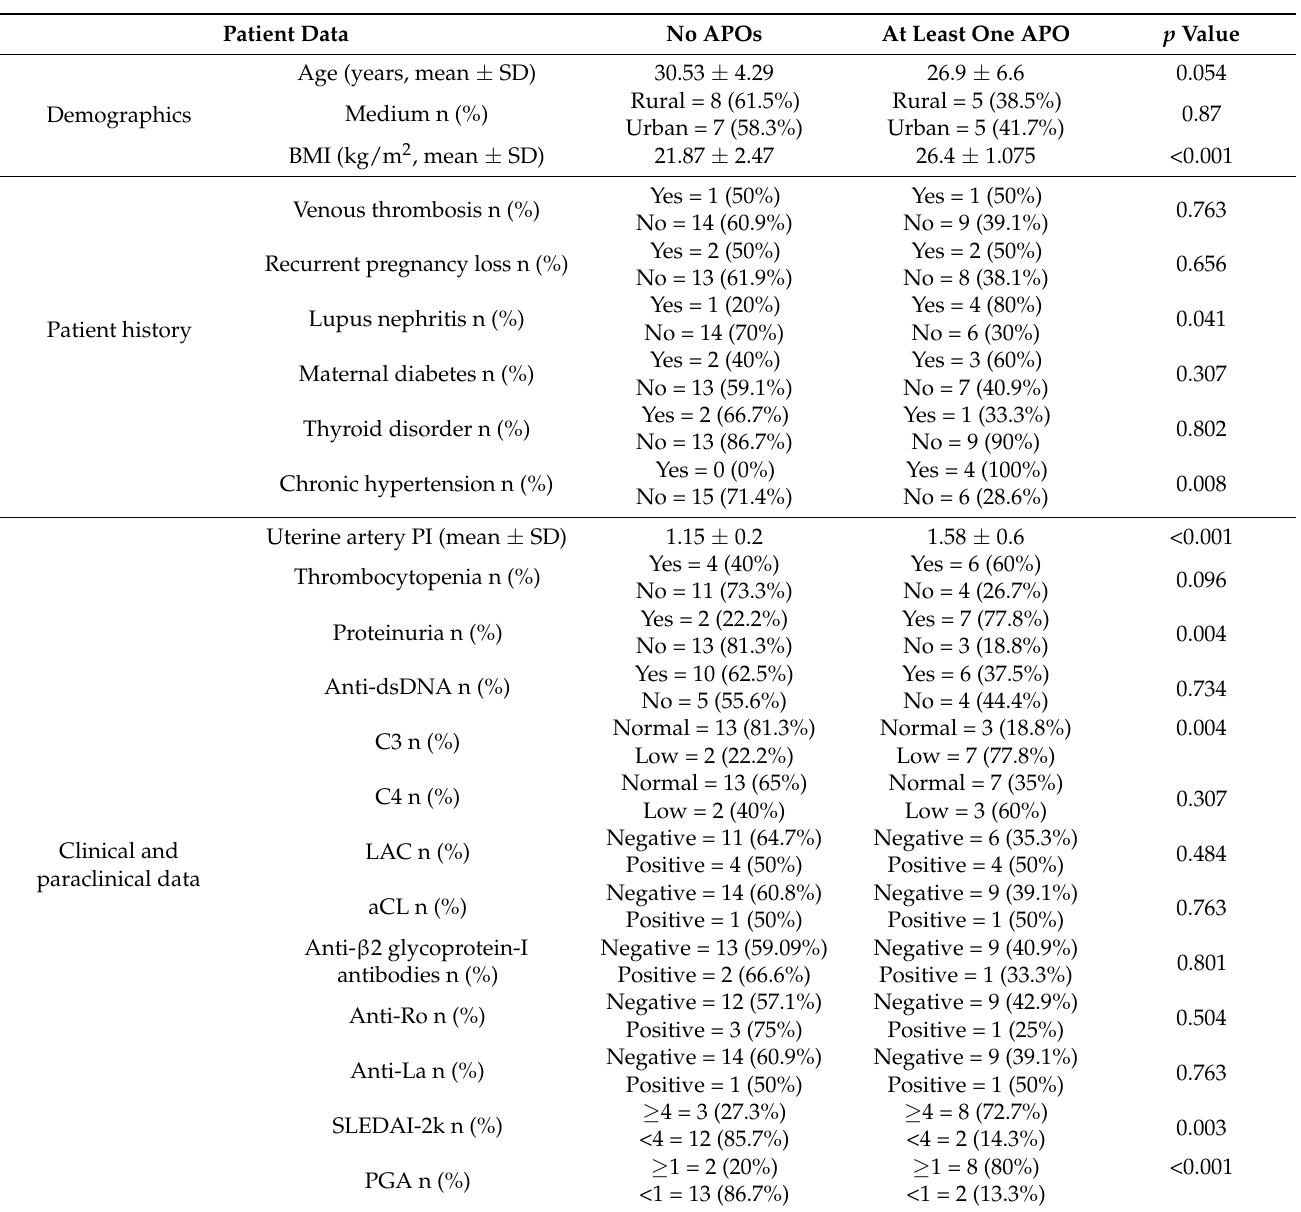
Table 1. Characteristics of pregnant SLE patients in the first trimester, and their association with adverse pregnancy outcomes